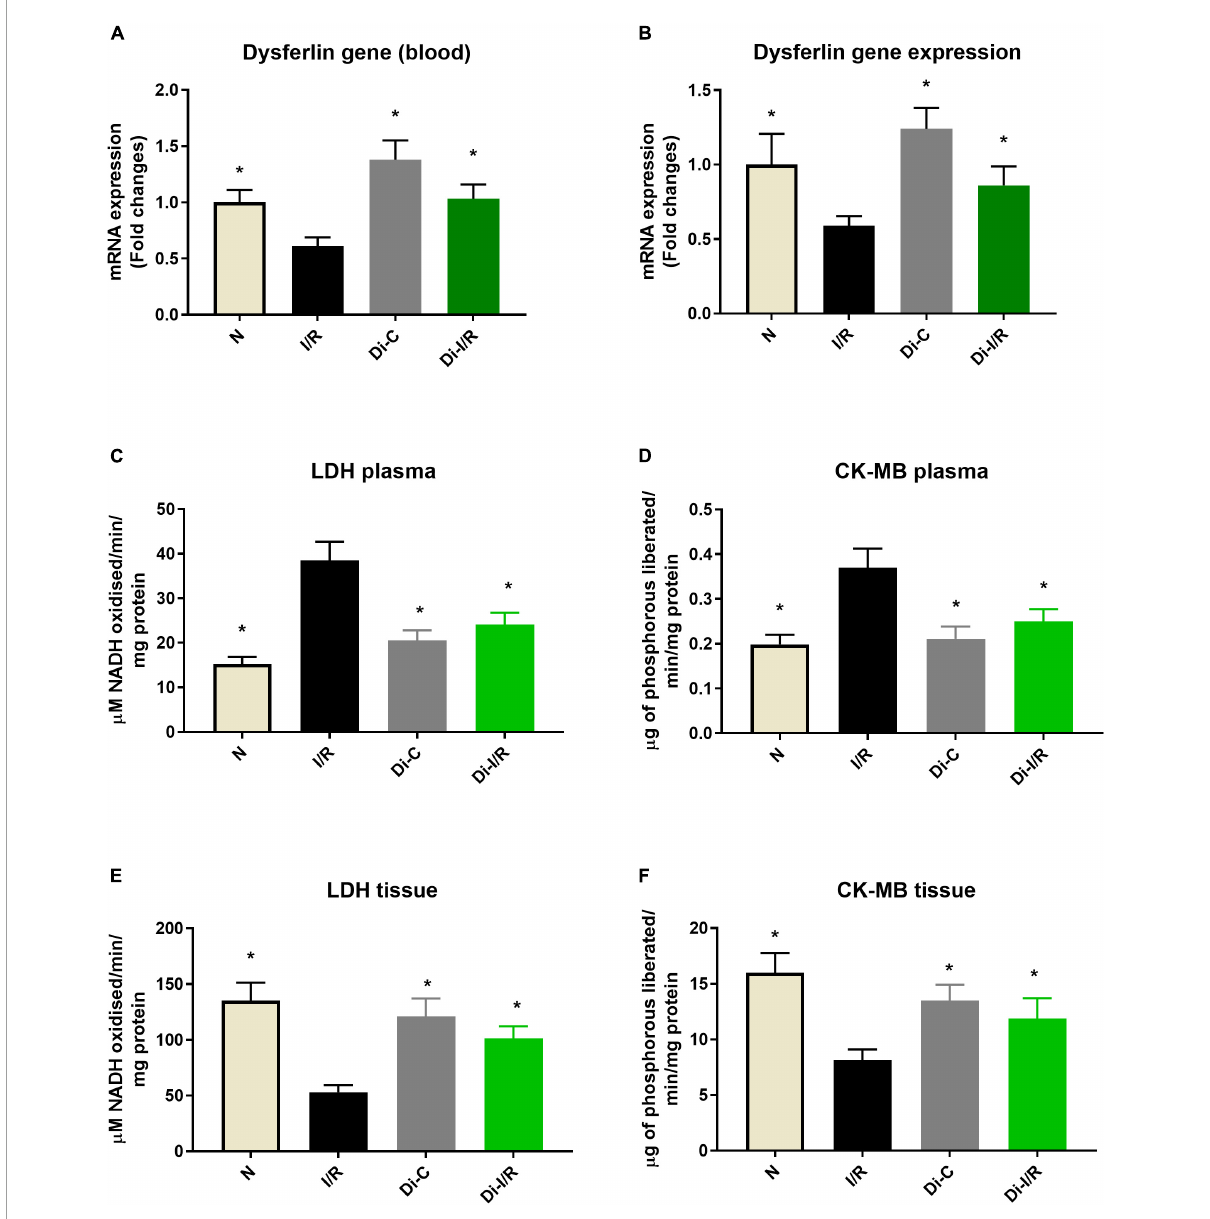
FIGURE3 DNA methylation inhibitor pre-treatment altered the I/R-associated cardiac injury markers in the heart and blood. (A) The dysferlin mRNA expression levels in the blood; panel (B) represents the dysferlin mRNA expression levels in the heart. The cardiac injury markers lactate dehydrogenase and creatine kinase were evaluated from the (C,D) plasma and (E,F) myocardium, respectively. The changes in gene expression are represented as fold changes from the normal group. The graphs represent mean ± SD values. * p < 0.05 vs.